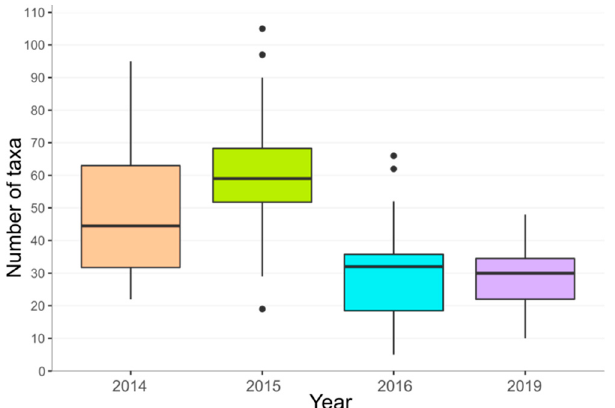
Figure 3. Comparison of the species richness of vascular plants and charophytes between individual years. Median values (= horizontal lines), lower and upper quartiles (= boxes, i.e., 50% of the observed values), 5% and 95% percentiles (= whiskers, i.e., 90% of the observed values), and outliers (= points, i.e., the values outside the 90% range) are displayed.